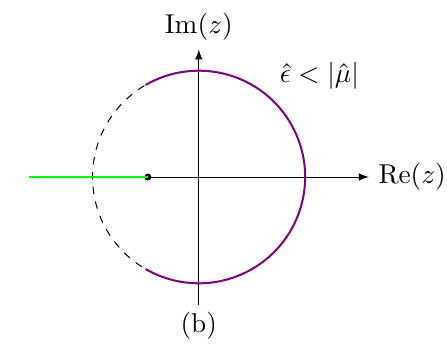
Figure 6 . Fermions in a lower gap phase: branch point is at z = − e ˆ (cid:15) −| ˆ µ | and is denoted by the black dot on the negative real axis. The green line is the branch cut for the logarithm appearing in the fermionic free energies. The dashed curve is the unit circle and the purple curve is the counterclockwise